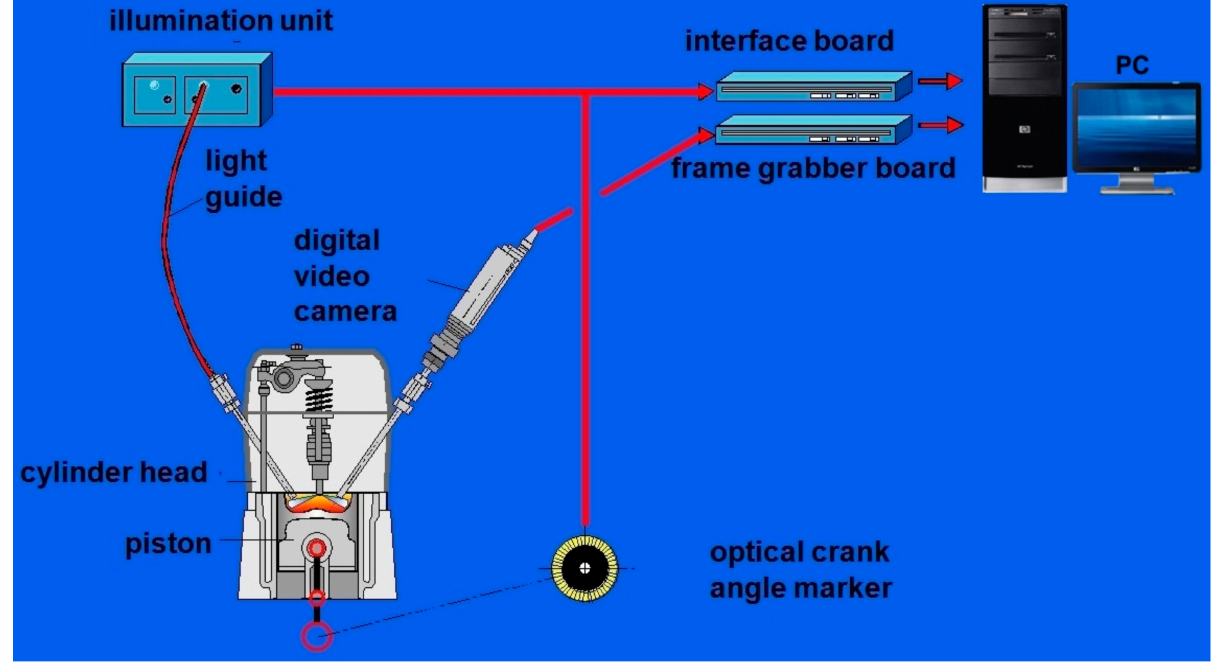
Figure 4. Test bench scheme for visualisation of fuel injection and combustion in AVL VideoScope 513D mounted to diesel engine